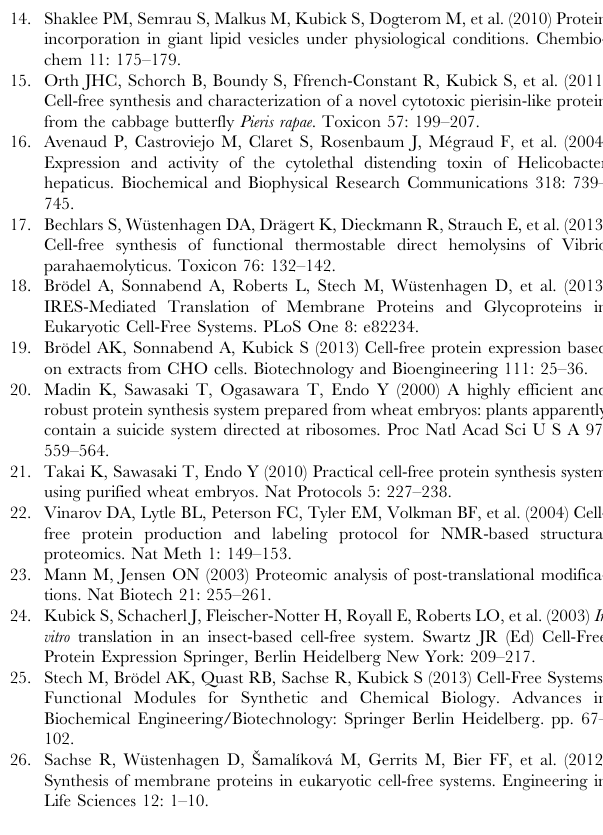
Figure S5 Glycosylation analysis of cell-free expressed Mel-EPO. Cell-free reactions were carried out in the presence of caspase inhibitor, 14 C-leucine and DTT using the insect batch and CECF system (48 h). The autoradiograph shows Mel-EPO in its glycosylated and non-glycosylated form. In addition, a deglycosy- lation assay was performed using PNGase F. Figure S6 FRAP analysis of the type-I transmembrane protein Mel-Hb-EGF-eYFP and the fluorescent and soluble protein eYFP. Both proteins were synthesized in standard batch reactions. For confocal microscopy, translation mixtures were excited at 488 nm while fluorescence emission was recorded with a longpass filter in the wavelength range above 505 nm (LSM 510 Meta, Zeiss). Strong emission intensity of de novo synthesized Mel-Hb-EGF-eYFP was observed in microsomal structures. In contrast to this observation, fluorescence of eYFP was observed in the cytosolic fraction of the lysate surrounding the vesicles. Samples were analyzed before and after photobleaching. Fluorescent vesicles of Mel-Hb-EGF-eYFP were bleached com- pletely after 500 iterations with 100% laser intensity (argon laser, 488 nm). As expected, no fluorescence recovery was observed after 50 s of incubation, indicating that membrane-embedded Mel-Hb- EGF-eYFP was not delivered by diffusion from the cytosolic surrounding. In contrast, laser exposure of the cytosolic protein eYFP did not result in a detectable photobleaching effect. Figure S7 Analysis of Mel-vtPA expression and activity. Synthesis of Mel-vtPA was performed in batch mode for 2 h using three different reaction buffers [(1) buffer with DTT; (2) buffer